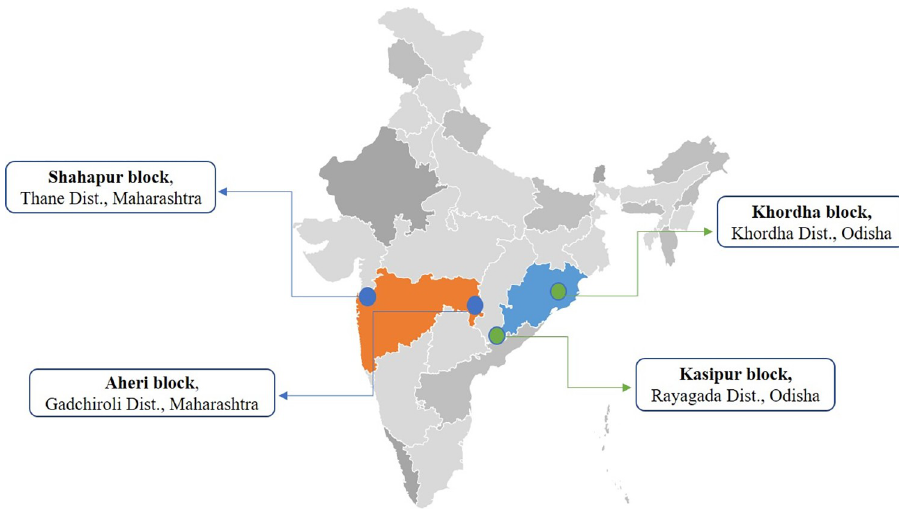
Fig 3. Geographical location of study areas of Maharashtra and Odisha states in India. Source: AMCHARTS SVG Maps; https://www.amcharts.com/svg-maps/?map=india2019. Permission obtained for use.